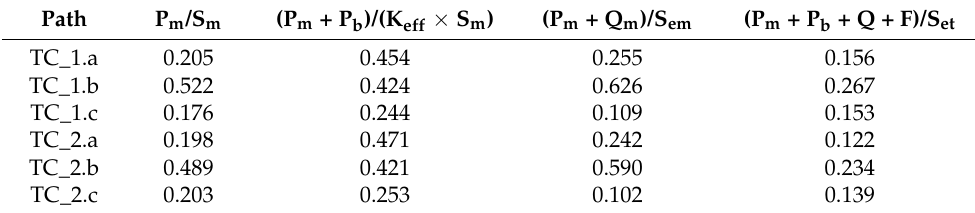
Table 7. RCC-MRx Level D criteria verification within TC domain.